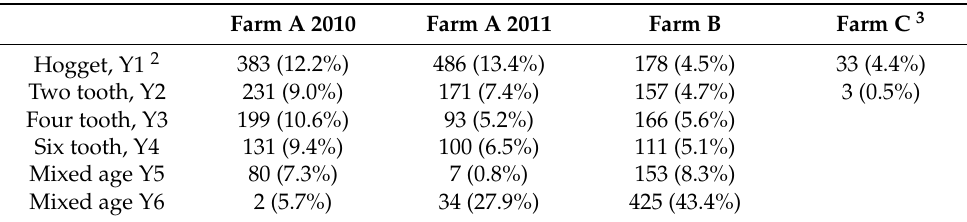
Table 6. Dead/missing from pregnancy diagnosis to weaning: of the ewes that the flock manager intended to retain until weaning (i.e., retain for lambing) 1 , the number (and %) of ewes that exited due to dead/missing during the period from pregnancy diagnosis to weaning (PD-W), for each study